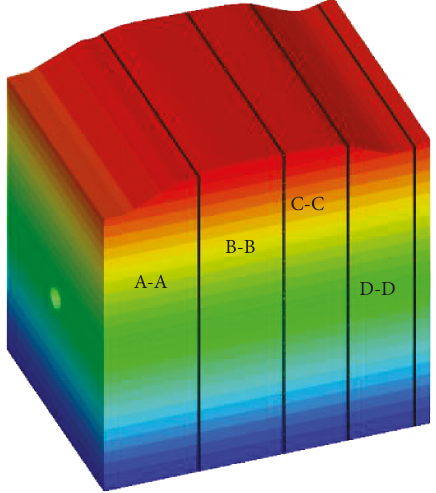
Figure 12: Excavation fractures.